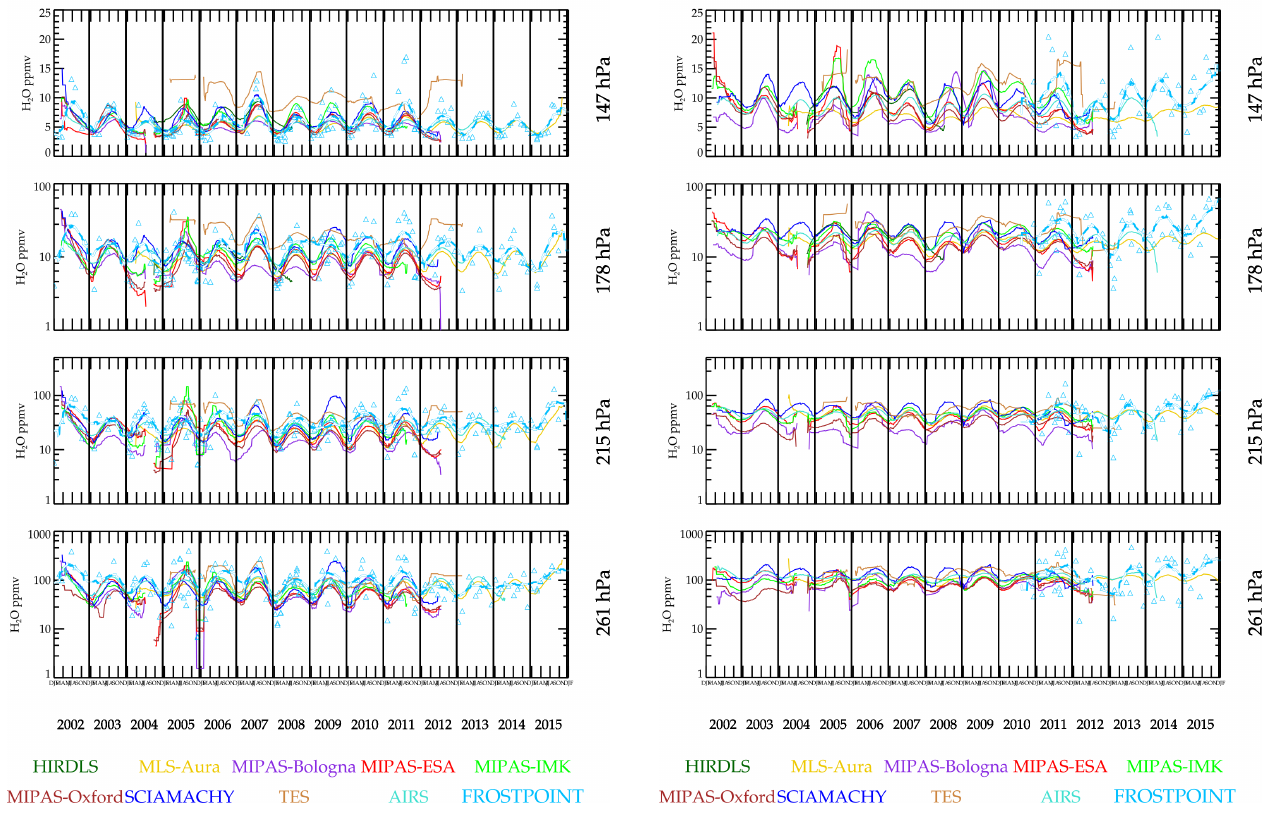
Figure 8. Same as Fig. 7 but for Hilo,